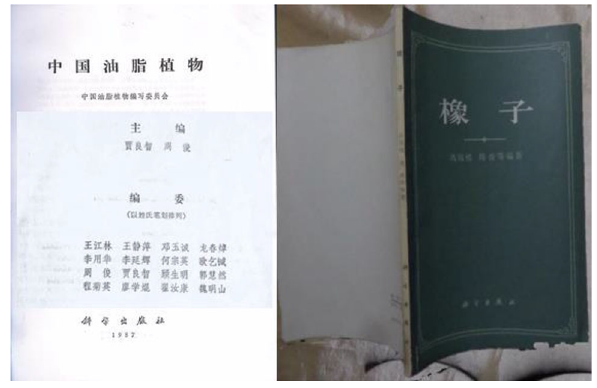
Fig. 2 Monographs: “Chinese oil plant ( 中 国 油 脂 植 物 )” and “Acorns ( 橡 子